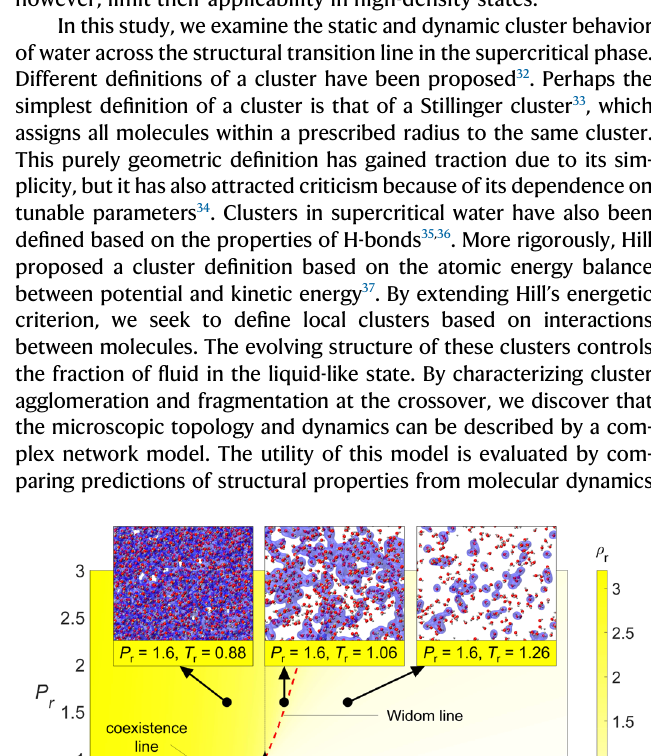
Nature Communications| (2023)